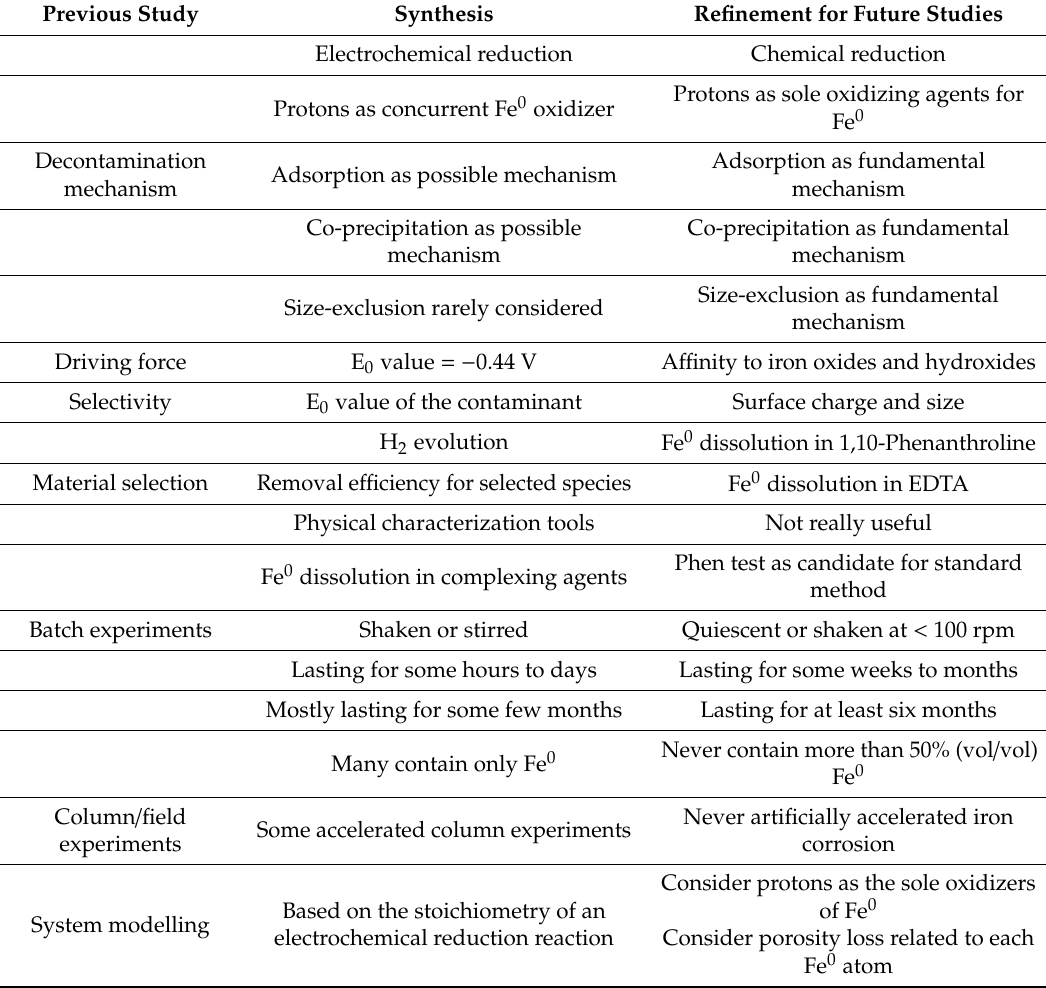
Table 3. Summary of synthesis of current knowledge and proposed refinements for future studies on Fe 0